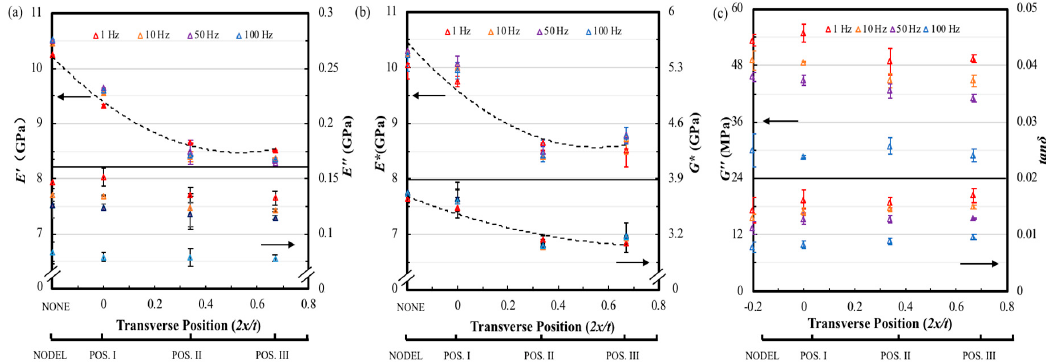
Figure 12. The dynamic mechanical properties of FFRP with different transverse delamination position tested at 25 °C, frequencies of 1, 10, 50 and 100 Hz, amplitude of 10 µm. Variation of ( a ) E’ and E” , ( b ) E* and G* and ( c ) tan δ with transverse delamination position.